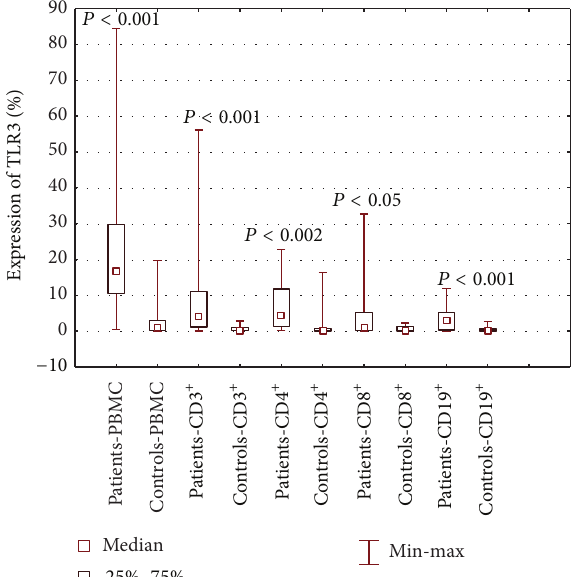
Figure 2: The percentage of PBMCs, lymphocytes B CD19 + , and lymphocytes T CD3 + , including CD4 + and CD8 + , expressing TLR3 in patients with SLE and healthy controls.